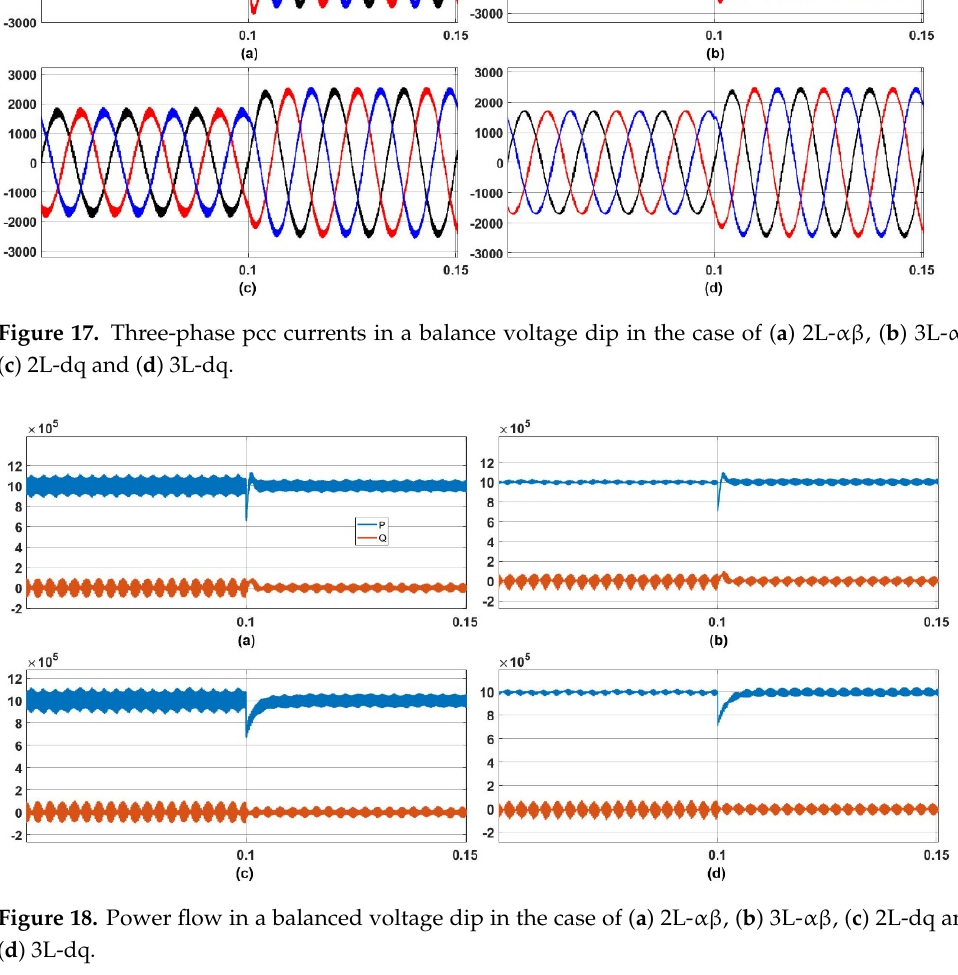
Figure 18. Power flow in a balanced voltage dip in the case of ( a ) 2L- αβ , ( b ) 3L- αβ , ( c ) 2L-dq and ( d ) 3L-dq .